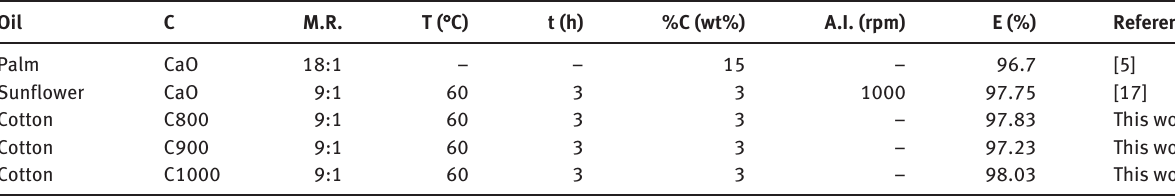
Table 1: Comparison between biodiesel of oil obtained in this work and